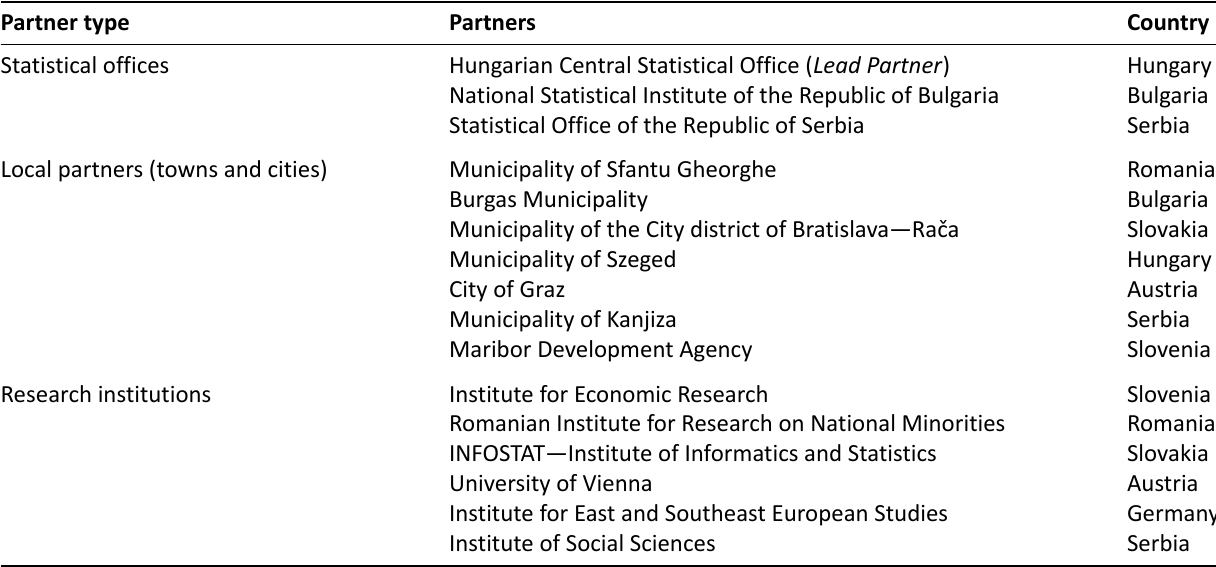
Table 1. Partner institutions represented in the consortium (excluding associated partners). Partner